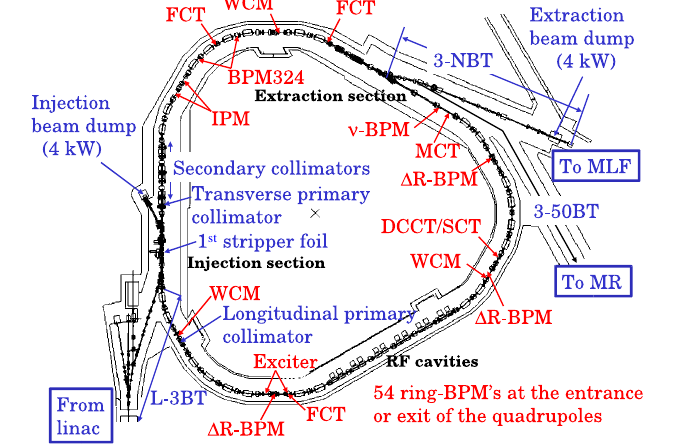
FIG. 1. (Color) Schematic view of the RCS, where the red characters correspond to the beam diagnostics devices which are defined in Table